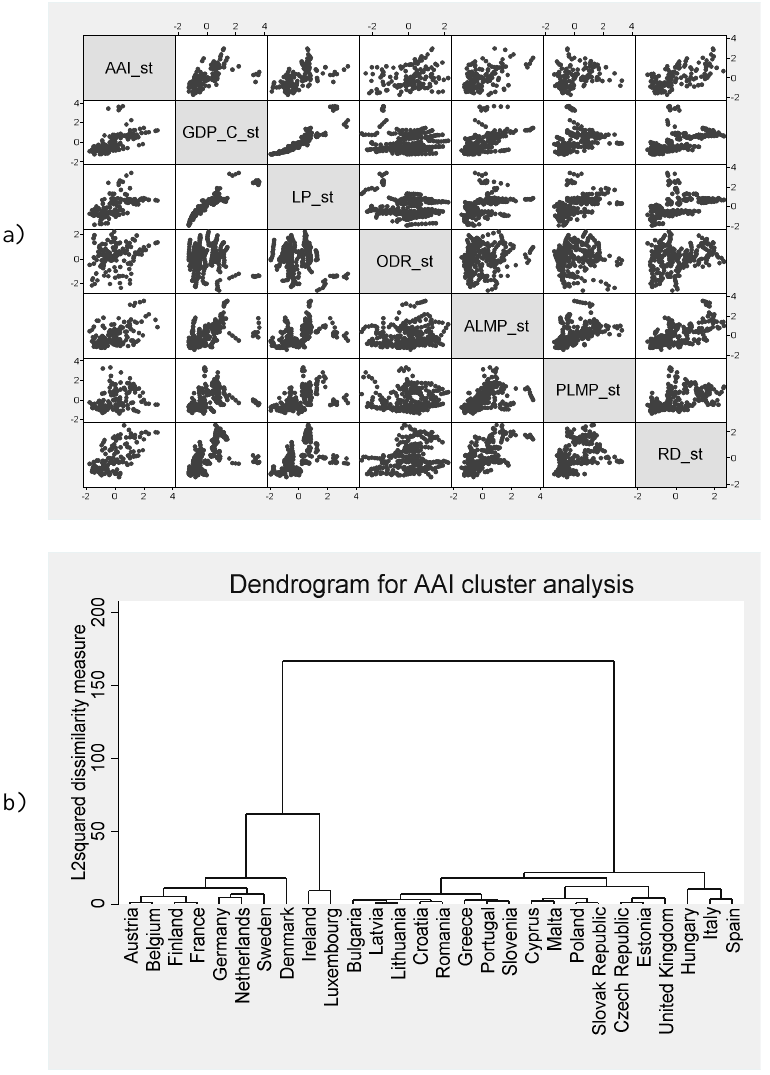
Figure 3. Correlation matrix (a) and dendrogram of cluster modelling (b), EU–28,